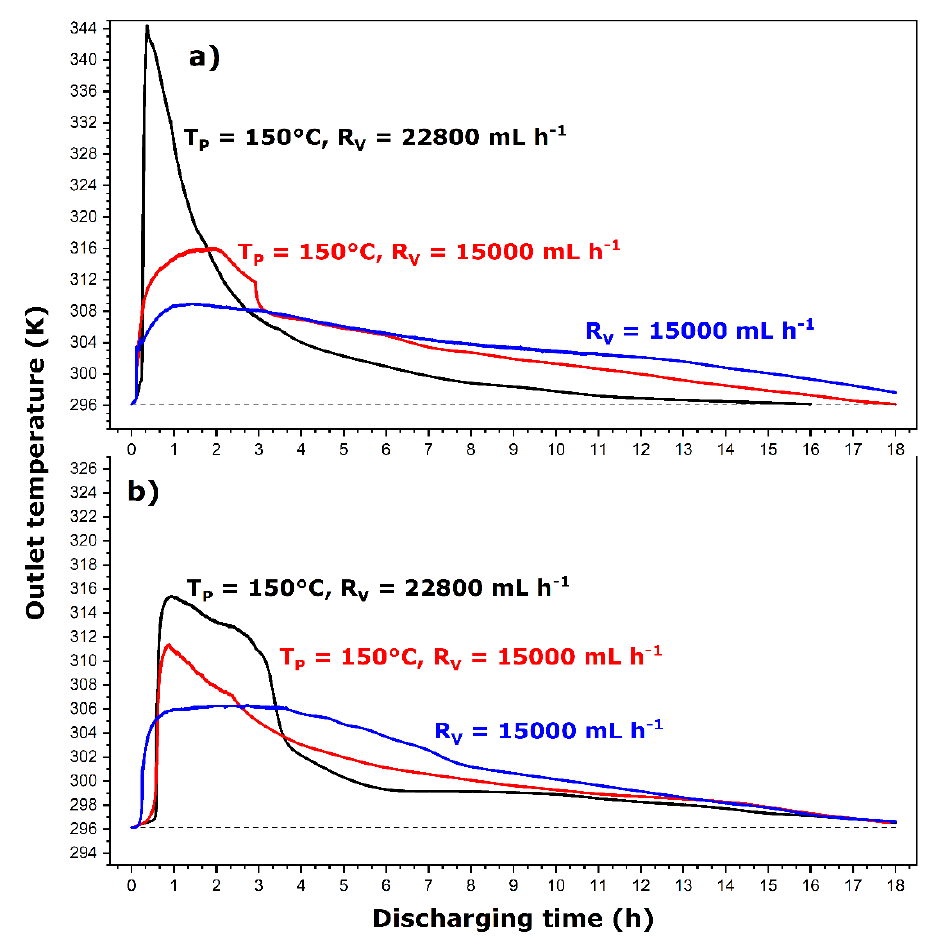
Figure 6. Variations of the temperature of gaseous nitrogen at the outlet of the 37 cm 3 adsorber recorded for Na-13X ( a ) and PBA ( b ) under different experimental conditions in the homemade laboratory-scale test rig (see Figure S3 in Supplementary Material): T P is the temperature of sample pre-treatment out of the rig and R V the volume flow rate of the carrier gas; the red and blue curves represent the first and the second cycles performed successively on the same sample. For the purpose of comparison, the maximum value on each y-axis corresponds to the maximum temperature predicted on the basis of Equation (1) and the data reported in Figure 5.